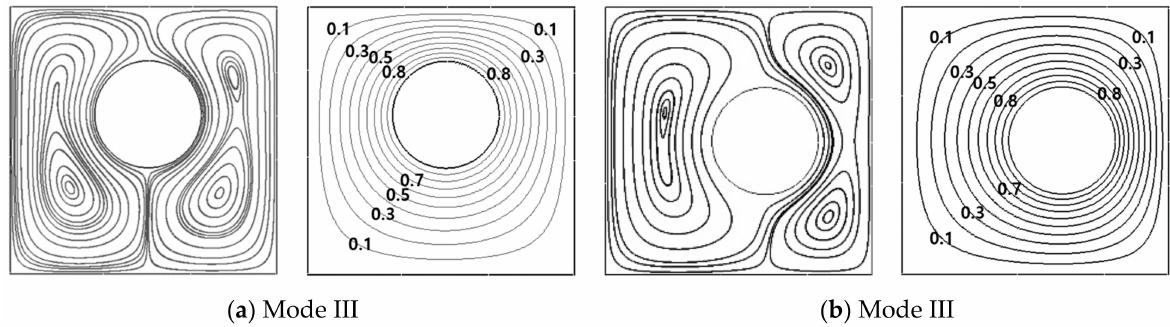
Figure 7. Streamlines (left column) and isotherms (right column) at ( a ) θ = 80 ◦ and ( b ) θ = 0 ◦ at a fixed r = 0.1 L for Ra = 10 3 .